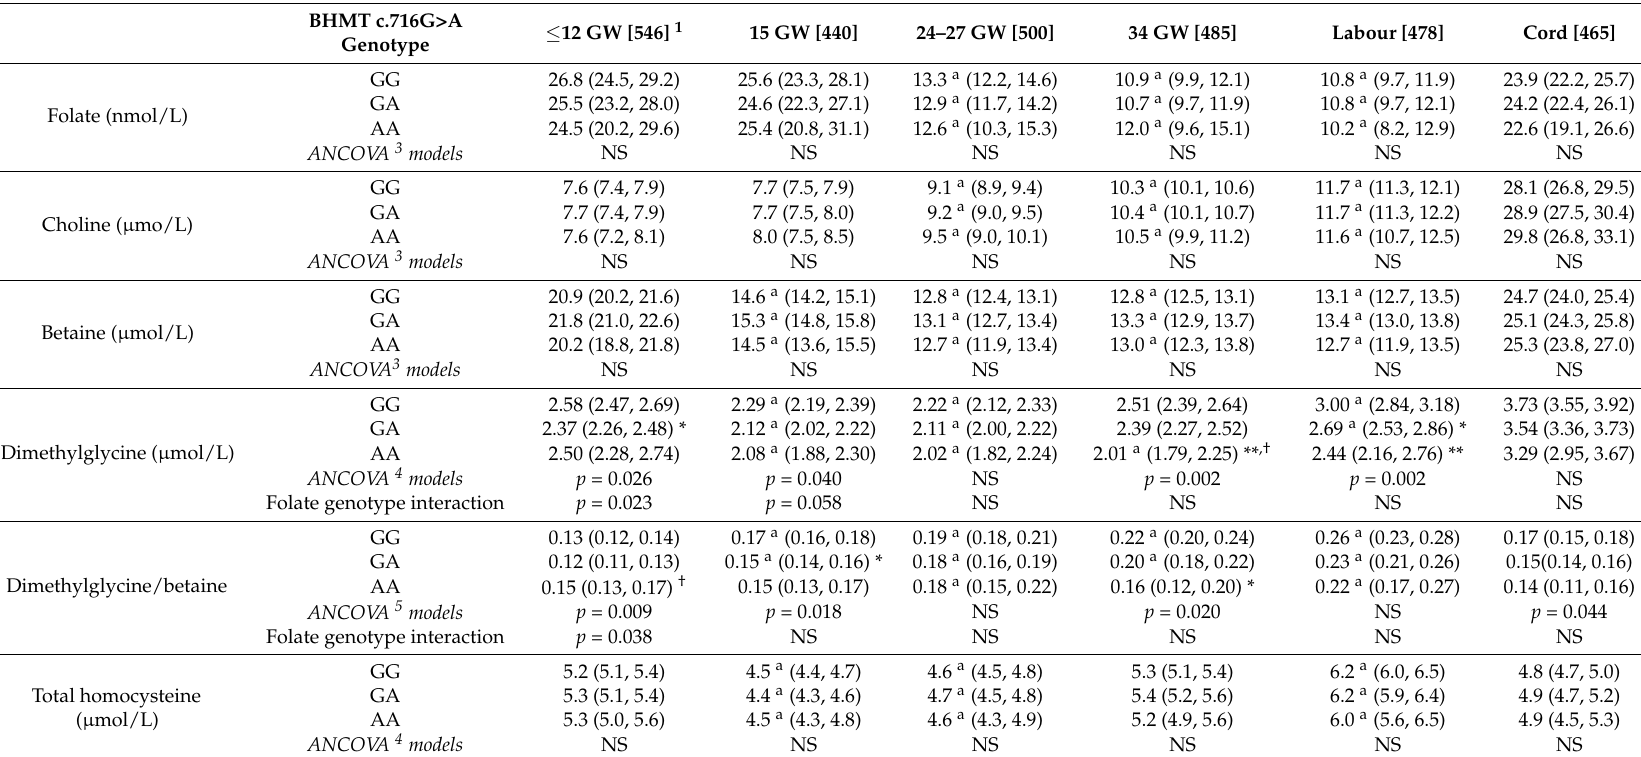
Table 2. Plasma folate, choline, betaine, dimethylglycine and tHcy during pregnancy and in the cord according to maternal BHMT c.716G>A